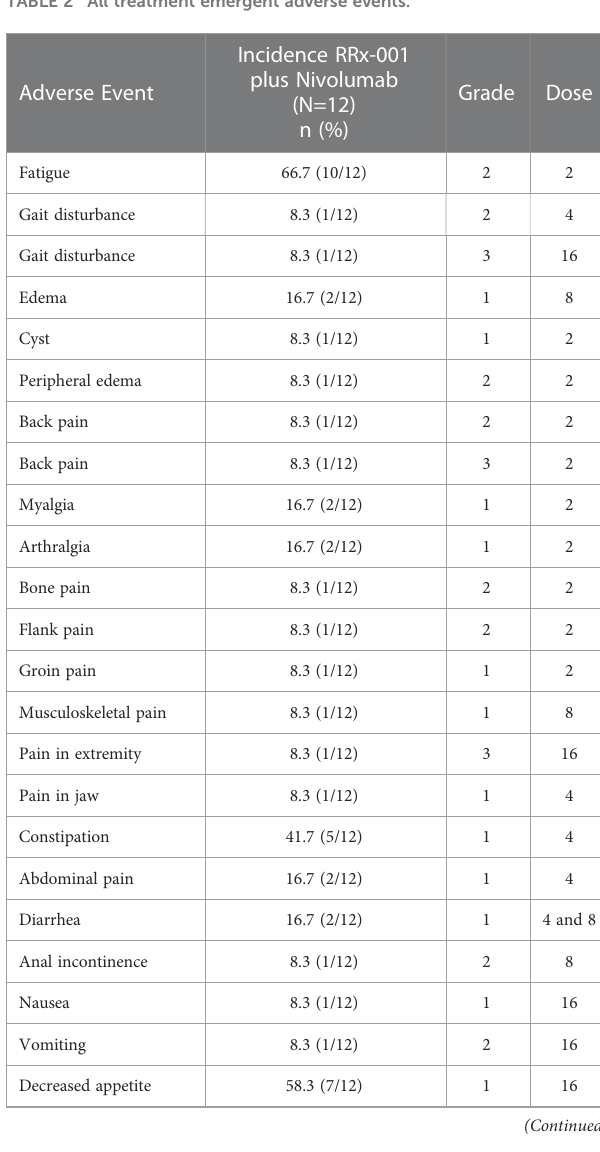
TABLE 2 All treatment emergent adverse